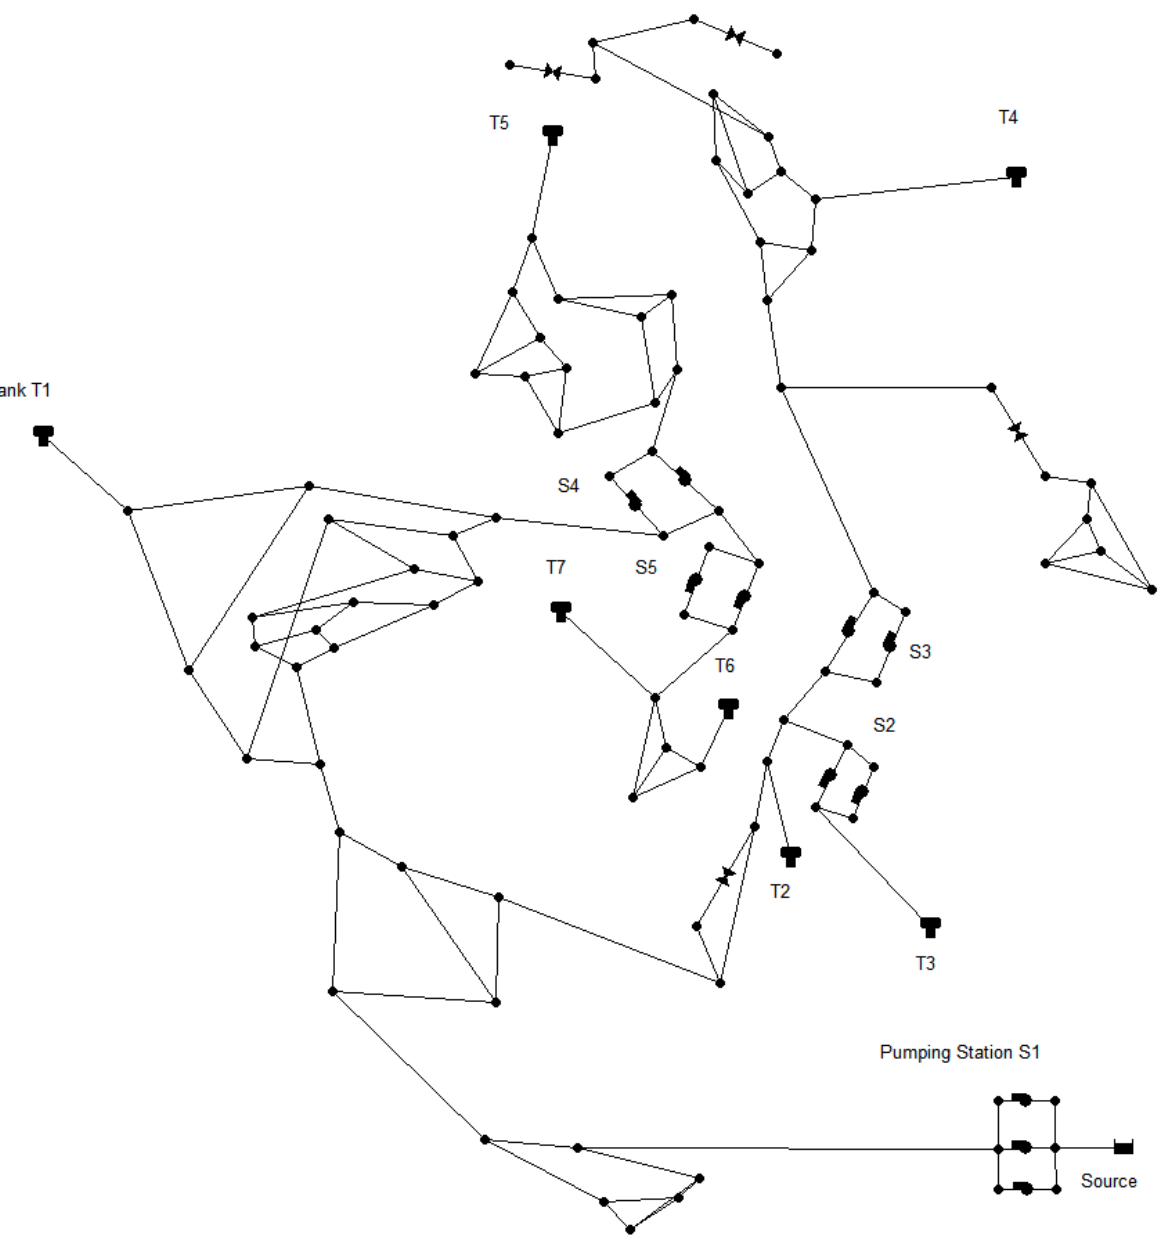
Figure 4. Skeletonized version of C-Town WDN.